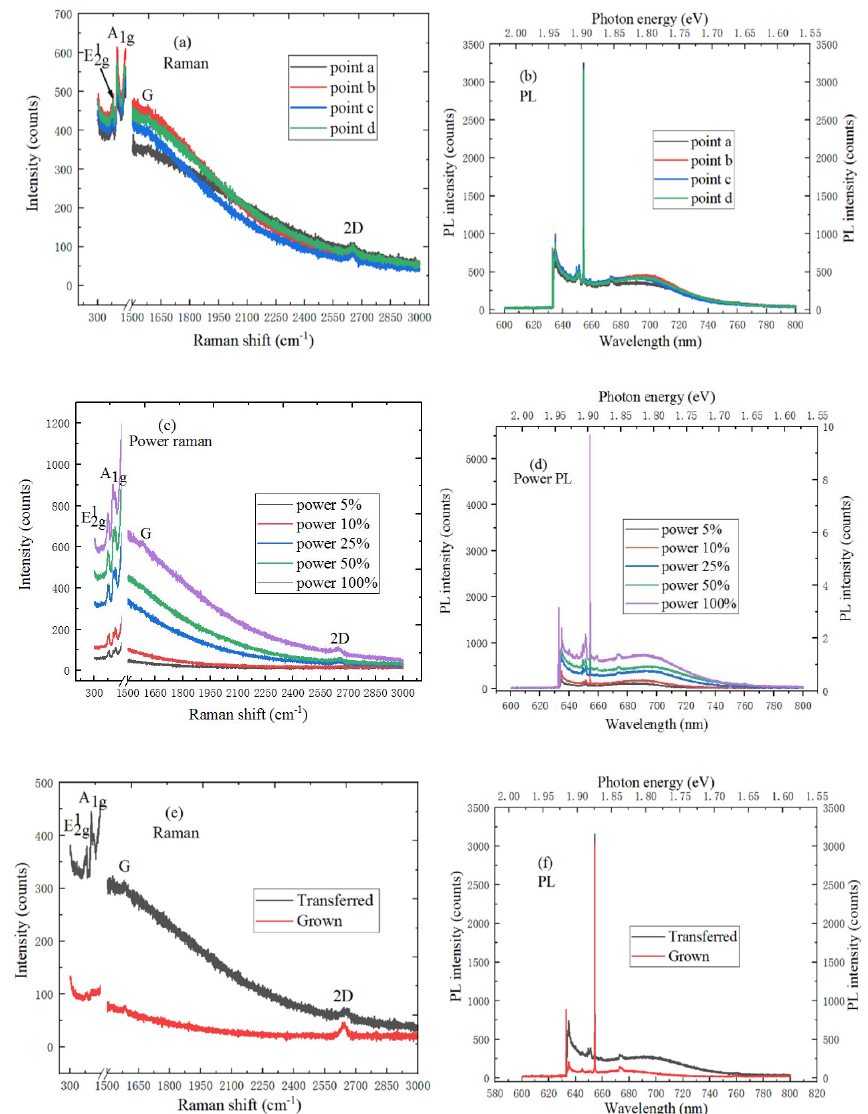
Figure 6. Spectral characteristics of MoS 2 /graphene heterostructure. ( a ) Raman spectrum (10 mW, 633 nm) and ( b ) PL spectrum (20 mW, 633 nm) at different positions; ( c ) power Raman spectrum (1 mW, 2 mW, 5 mW, 10 mW, 20 mW and 633 nm), ( d ) power PL spectrum (1 mW, 2 mW, 5 mW, 10 mW, 20 mW and 633 nm); ( e ) Raman spectrum (10 mW, 633 nm) and ( f ) PL spectrum (20 mW, 633 nm) comparison between MoS 2 sample directly grown on a graphene and MoS 2 sample trans- ferred on a graphene.